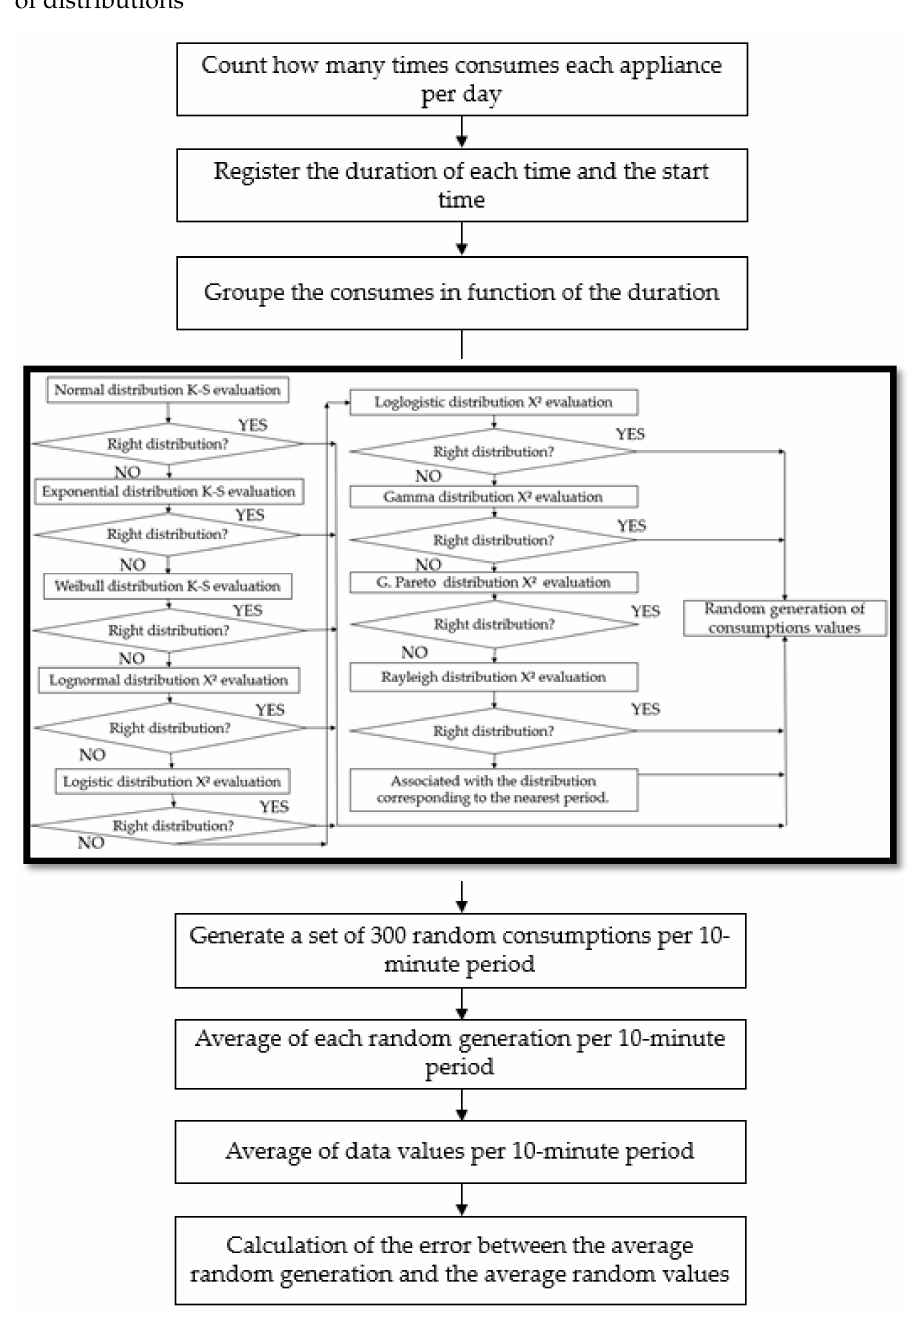
Figure 3. Flowchart of the treatment of the punctual consumptions. The simulation was carried out with the consumption data of a house, with 199 m 2 and three occupants, located in Vancouver. The extrapolation of results can be done in